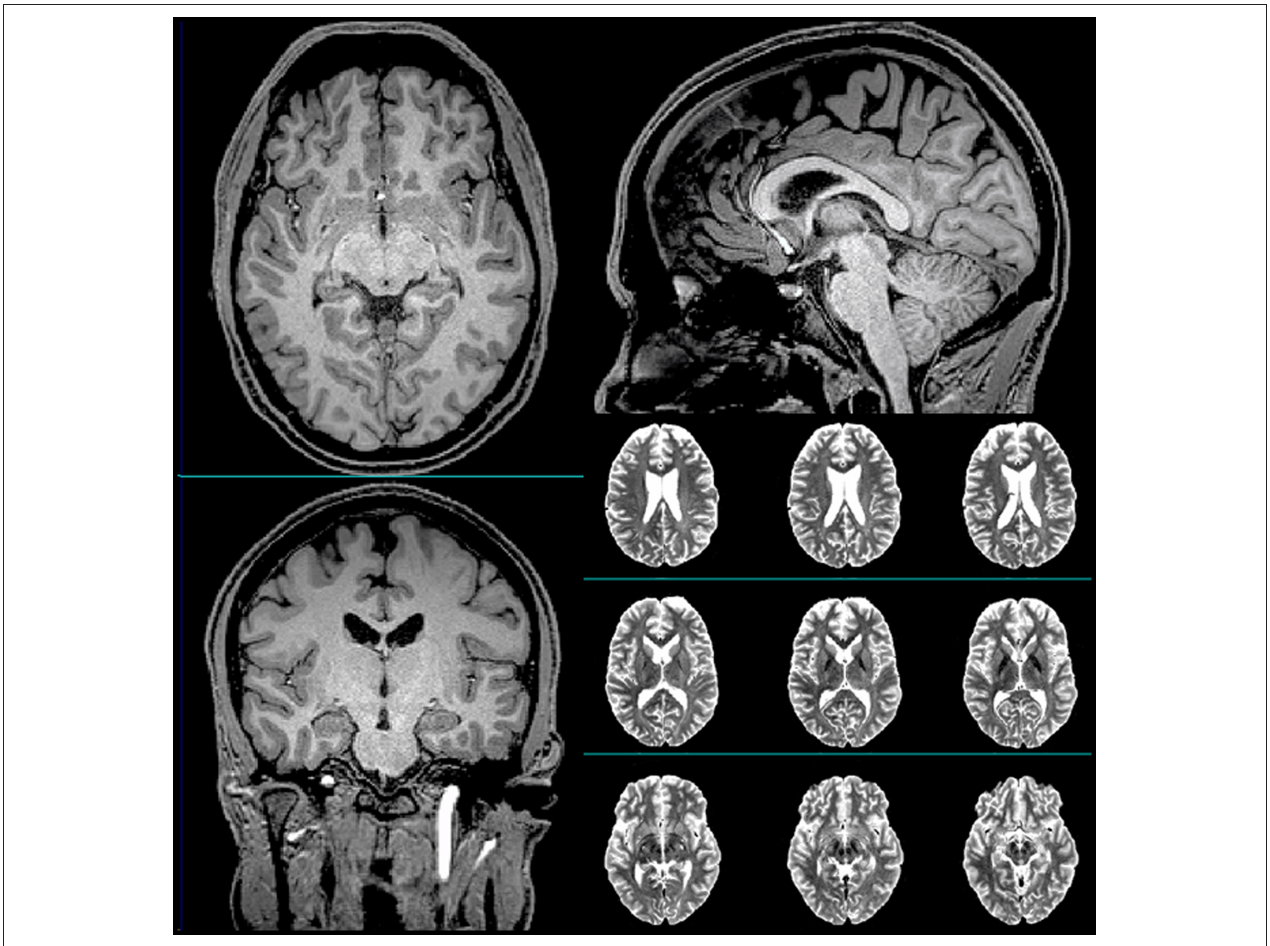
FIGURE 1 | Representative T1-weighted (axial, sagittal, and coronal) and T2-weighted (axial) anatomical scans of the subject acquired at baseline.